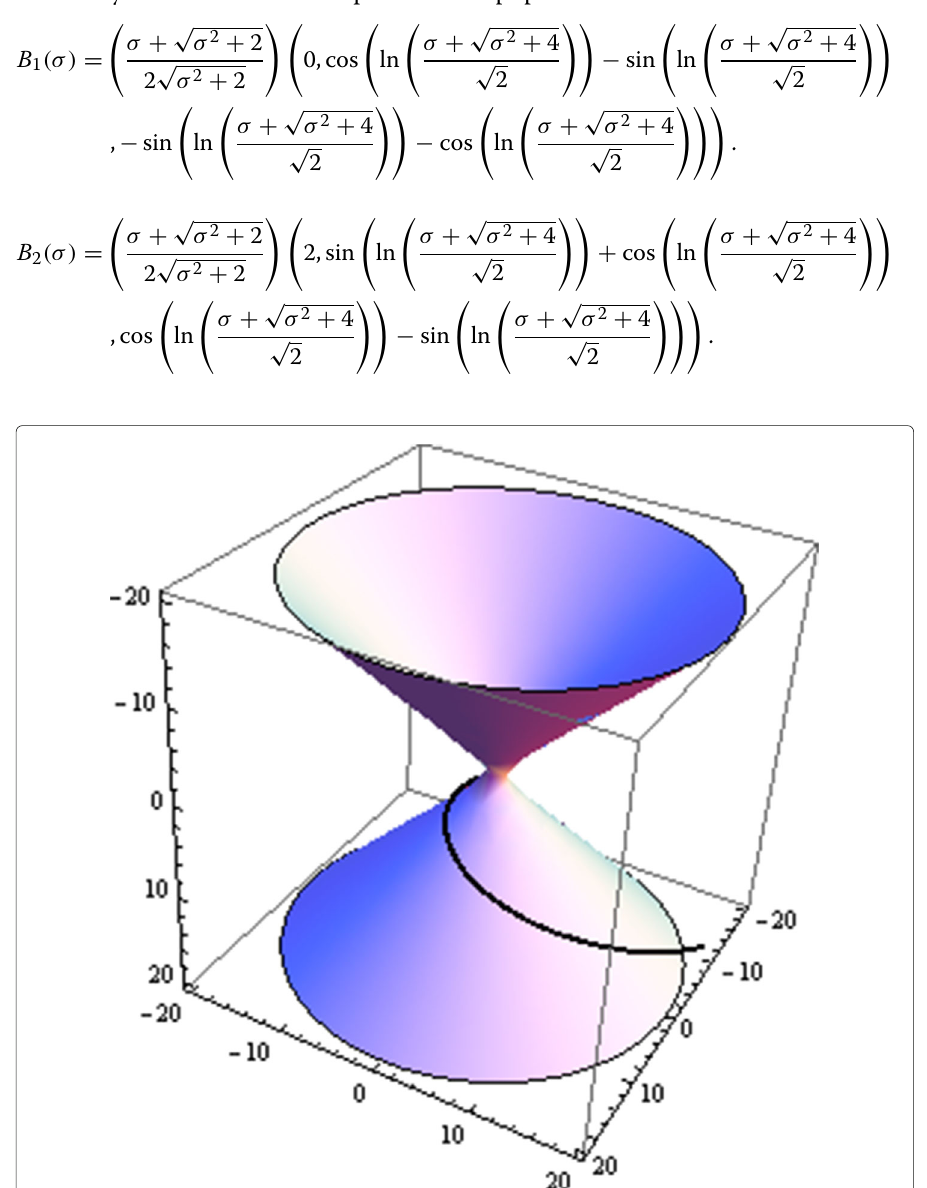
Fig. 3 The spacelike equiform-Bishop TB 1 -Smarandache curve ϕ(σ ∗ ) on S 2